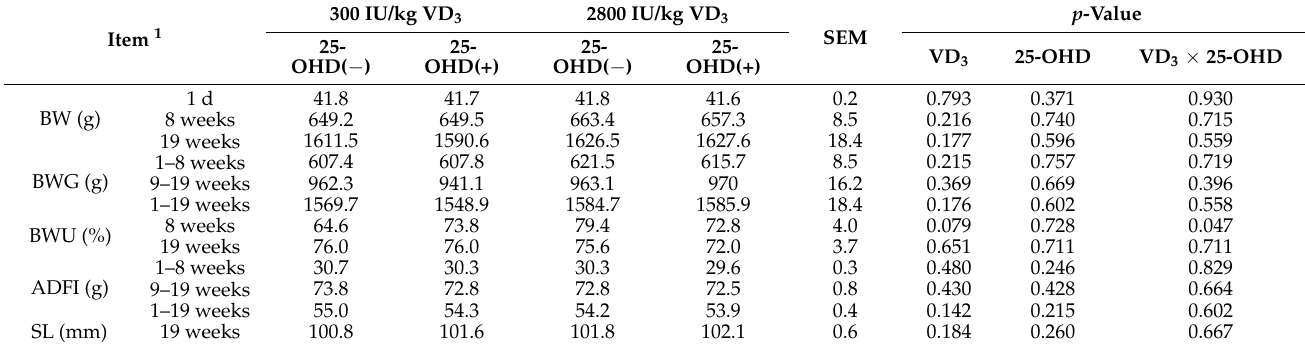
Table 2. Effects of dietary VD 3 level and 25-OHD on growth performance of laying hens.